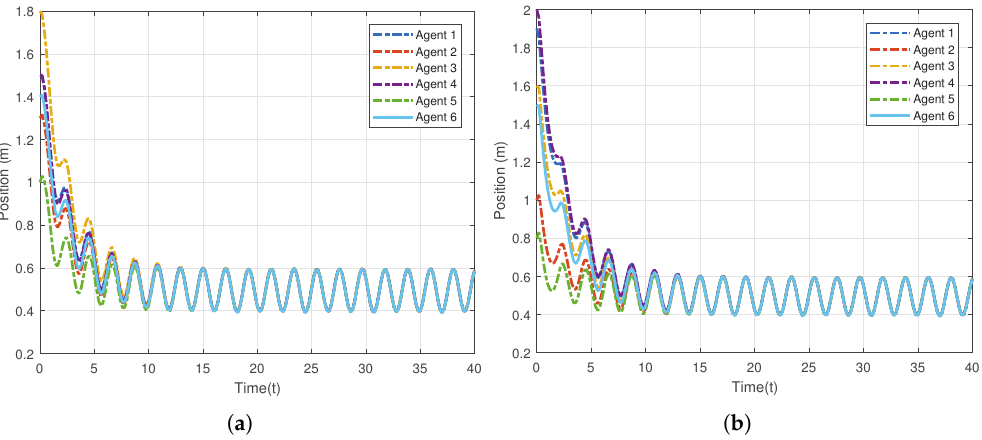
Figure 4. Positions of the agents in the networked Euler-Lagrange system. ( a ) Actual positions on X-axis; ( b ) Actual positions on